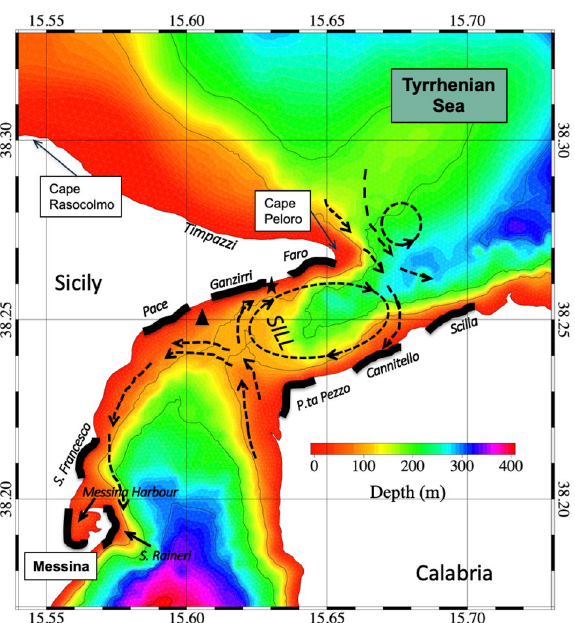
Figure 2. The Strait of Messina: the main morphological and bathymetrical features are indicated. The residual current pattern (redrawn from 52 ) is superimposed (black arrows): (i) the advective eddy at the entrance of the Strait, in the lee side of Cape Peloro (ii) the anticyclonic recirculation pattern just north of the sill and (iii) the cyclonic residual circulation south of the sill can be recognized. The black star indicates the position of the ENERMAR-Kobold platform that provided water temperature near the seabed and current velocity data; the black triangle indicates the CTD station (T/S profiles). The 1-km-long stretches of coast monthly surveyed for jellyfish strandings are highlighted in black (six along the Sicilian coast; three along the Calabrian coast). Map was generated by SHYFEM v. 7.5 with the embedded visualization tool “shyplot” (https:// github. com/ SHYFEM- model/